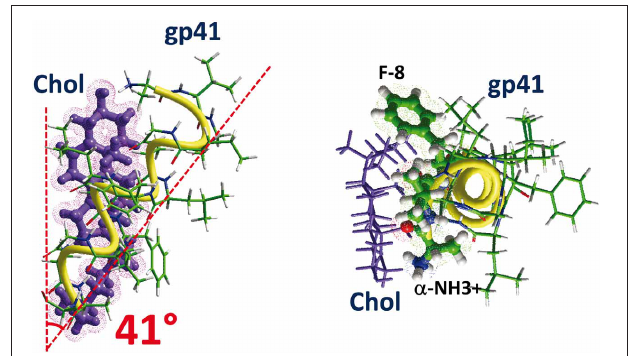
FIGURE 8 | How cholesterol interacts with a tilted peptide. Docking of cholesterol with the N-terminal part of HIV-1 gp41, i.e., the fusion peptide. The apolar part of cholesterol interacts with the aromatic ring of F-8 through CH- π (but not stacking) interactions. The OH group of cholesterol is close to the α -NH3 + group of the peptide (N-terminus ending). The angle between the helix axis of the tilted fragment of the fusogenic tilted peptide of gp41 is 41 ◦ . The calculated energy of interaction is − 48.5kJ.mol − 1